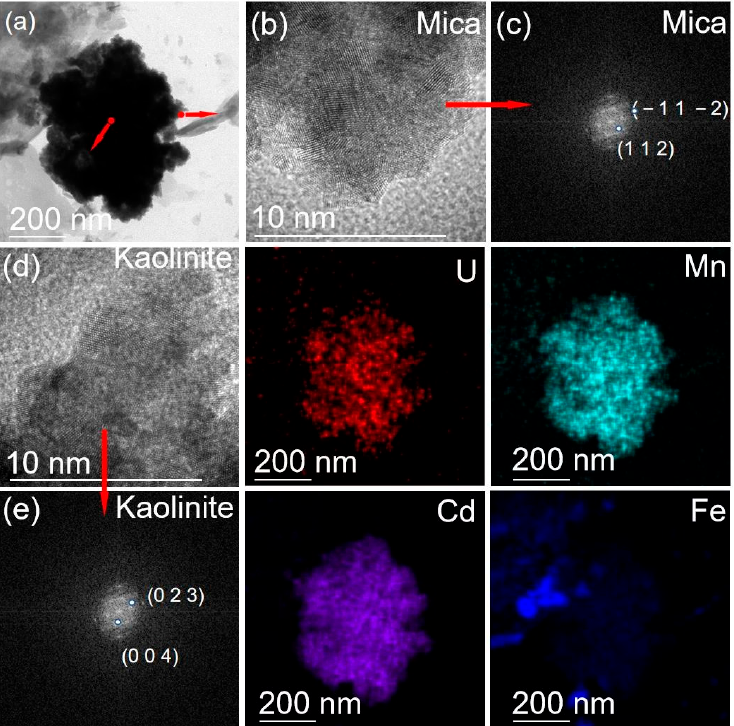
Figure 4. TEM mappings of selected S2 soil sample. ( a ) TEM image; ( b , d ) HRTEM image; ( c , e ) FFT image EM maps of particle.